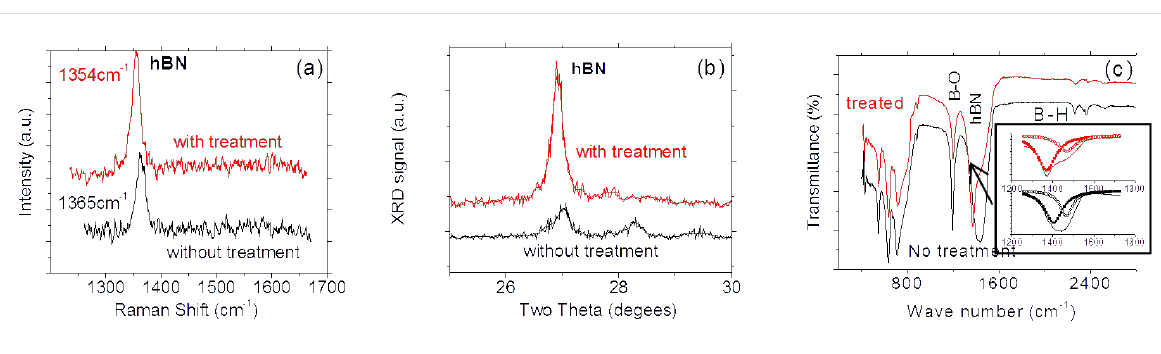
Raman active E 2g mode of BNNSs with the hexagonal